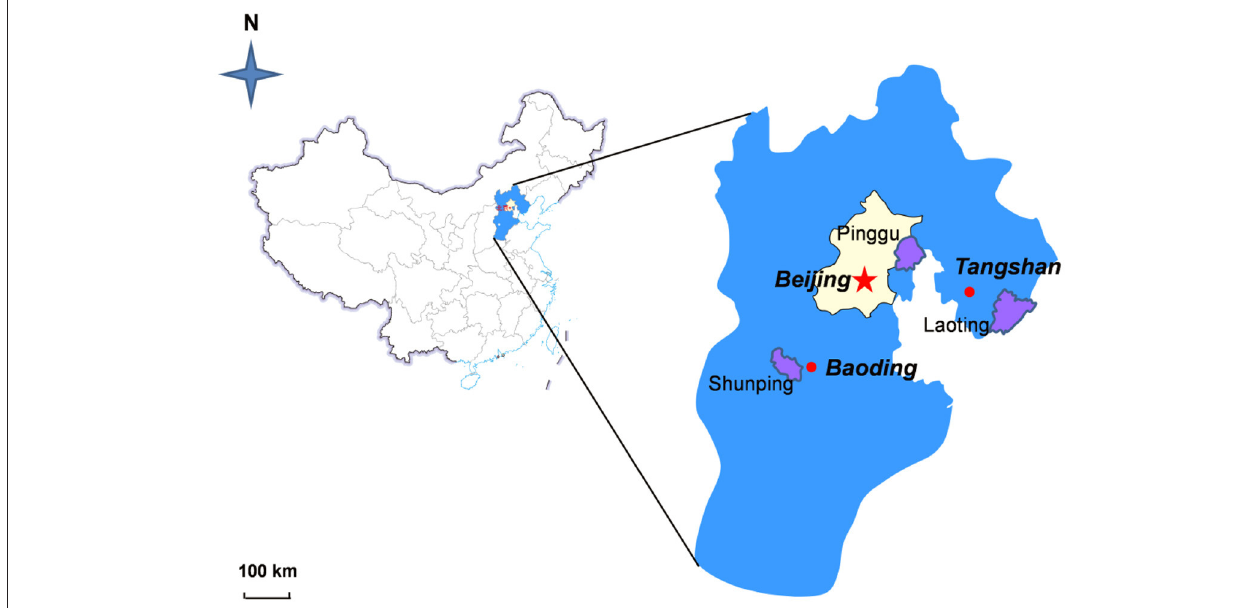
FIGURE 1 | Geographical map of peach sampling sites from different regions in China and the specific localities of peach samples within Pinggu (Beijing, capital city), Shunping (Hebei province), and Laoting (Hebei